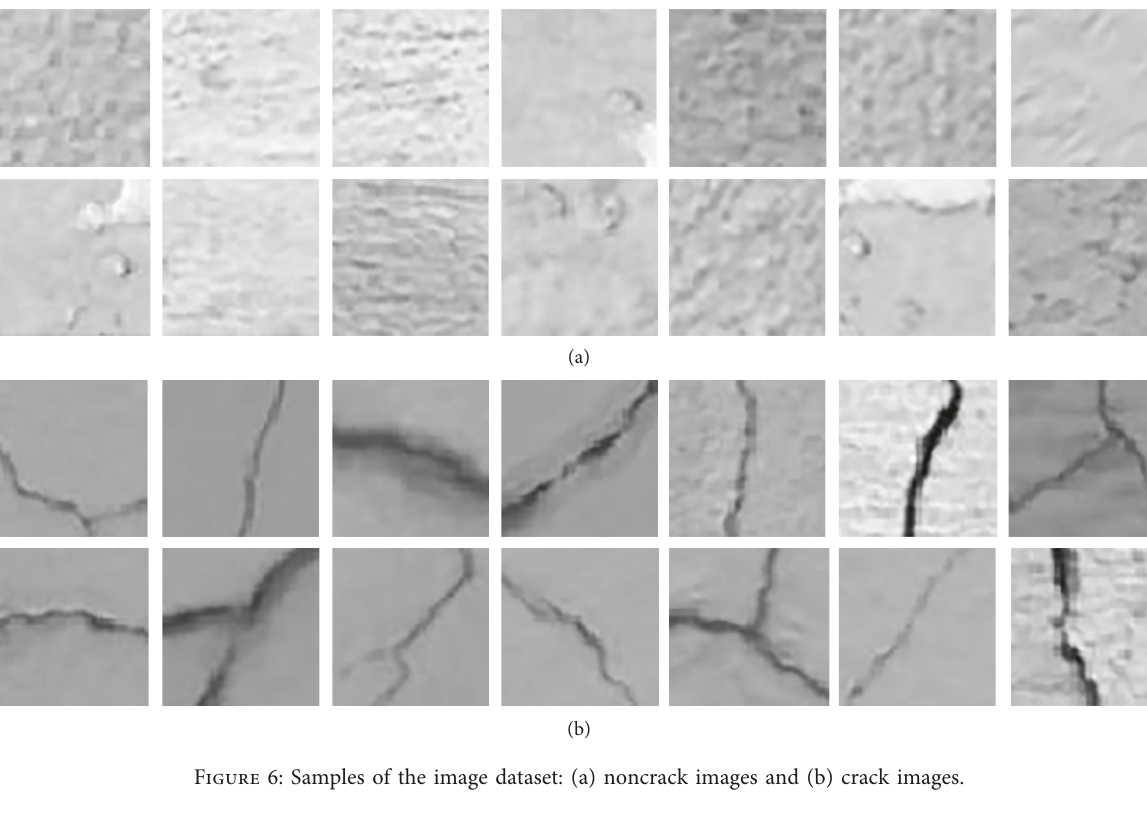
Figure 6: Samples of the image dataset: (a) noncrack images and (b) crack images.